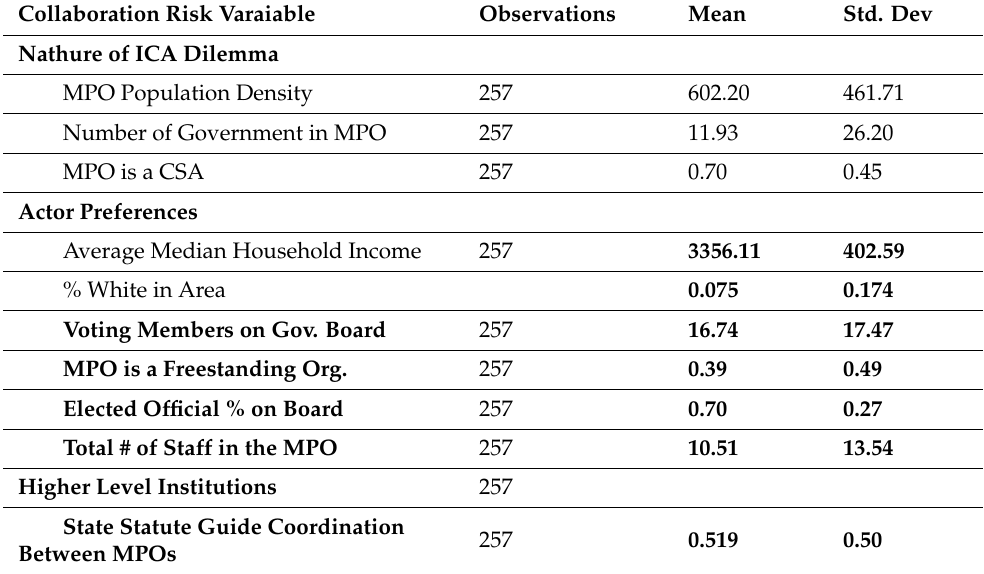
Table 3. Summary